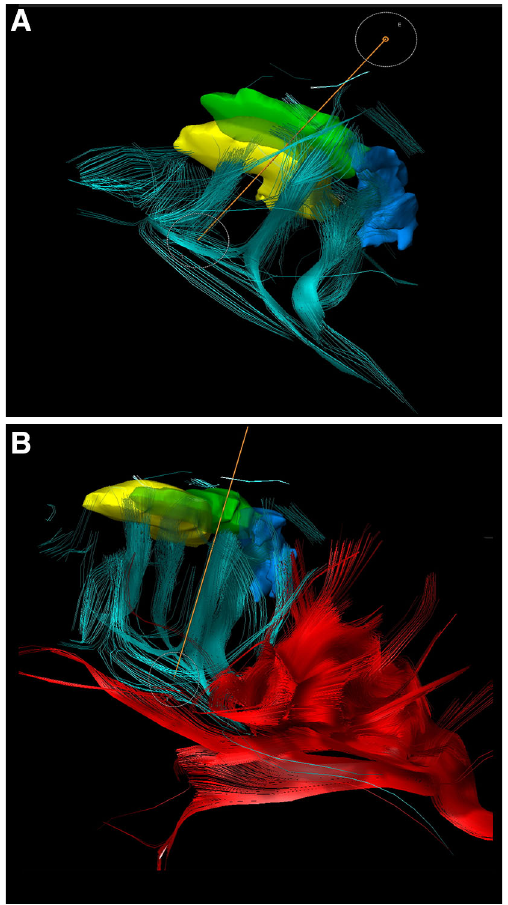
Fig. 1 3D reconstruction of fiber tracking showing the parcellated cortical areas with corresponding connection fibers. a Fibers between parcellated cortical areas. b Additional tracking of the arcuate fascicle (as a part of SLF) showing the direct connectivity to the cortex segmentated in green . (Color figure